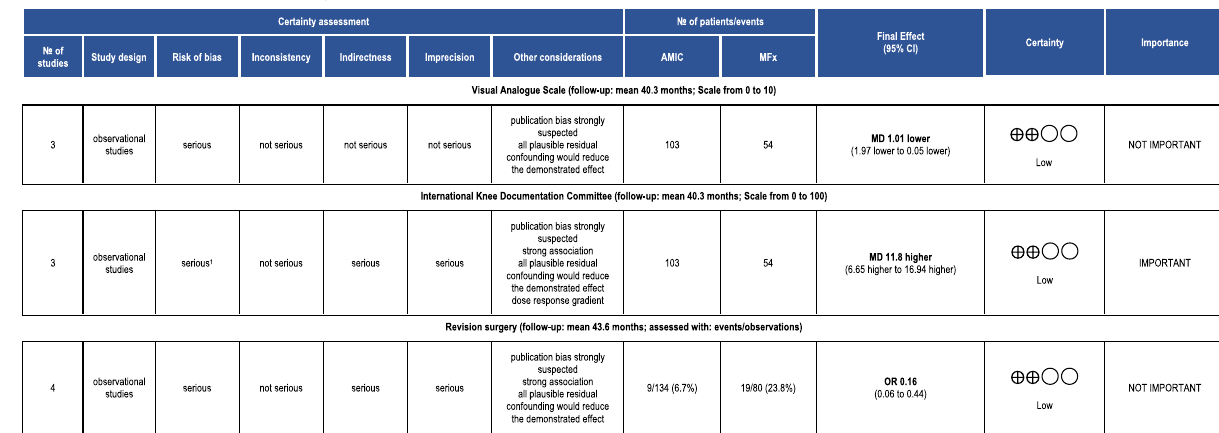
Figure 4. The overall quality of evidence of collective outcomes according to the GRADE approach was